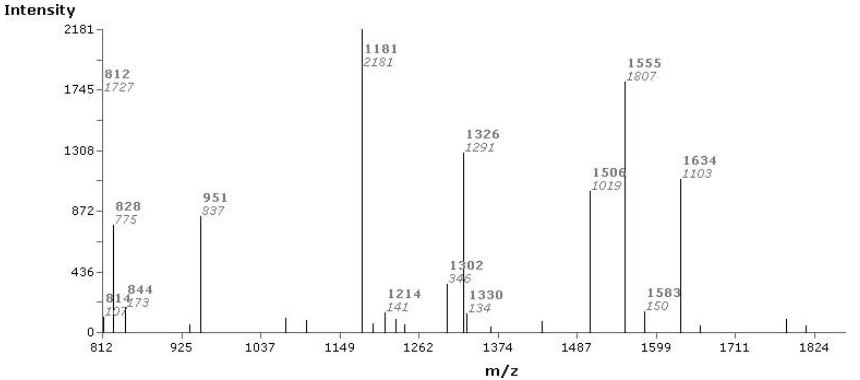
Figure 2. Peptide Mass Fingerprint Identified as Alpha-Synuclein in Mus musculus (IPI00115157) During the HUPO Brain Proteome Pilot Study The bold numbers associated with each peak are the m/z value, while the italic numbers associated with each peak show the intensity value. This ‘‘ stick ’’ spectrum has been processed from the raw output of the mass spectrometer. Available at http://www.ebi.ac.uk/pride/viewSpectrum. do?mzDataAccession ¼ 1681&spectrumReference ¼ 10021.